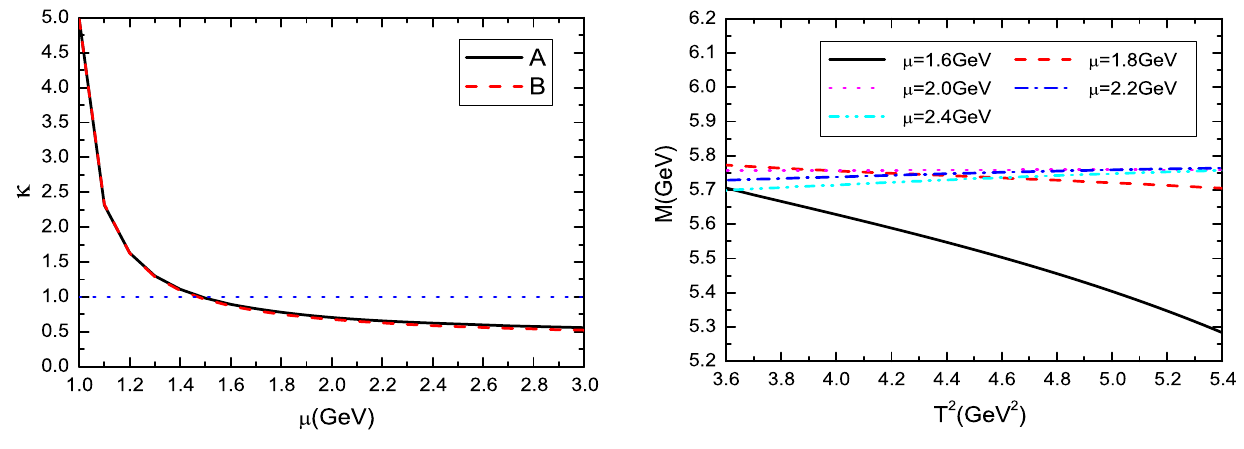
Fig. 7 The mass M X ( cc ¯ c ¯ c , 0 ++ ) with variation of the Borel parameter T 2 from Eqs. (29, 30)